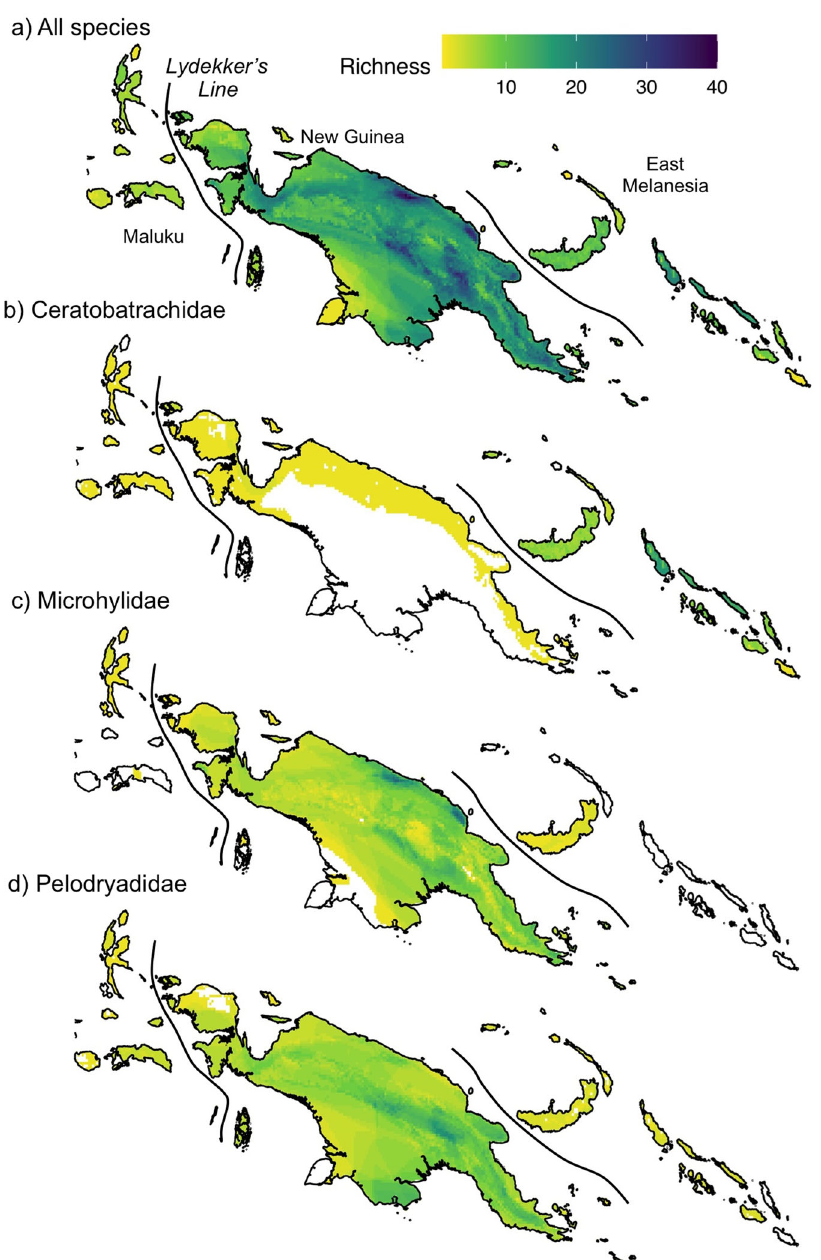
Fig. 3 Frog species richness in Melanesia based on IUCN distributional maps for all species described by 2019. a All species; b Ceratobatrachidae; c Microhylidae; d Pelodryadidae. Areas of highest estimated diversity correspond to mountain ranges in central and northern New Guinea. The boundaries between Maluku, New Guinea and East Melanesia are indicated. Fiji has only two frog species and is geographically distant from other areas of Melanesia inhabited by frogs and is not visble on this